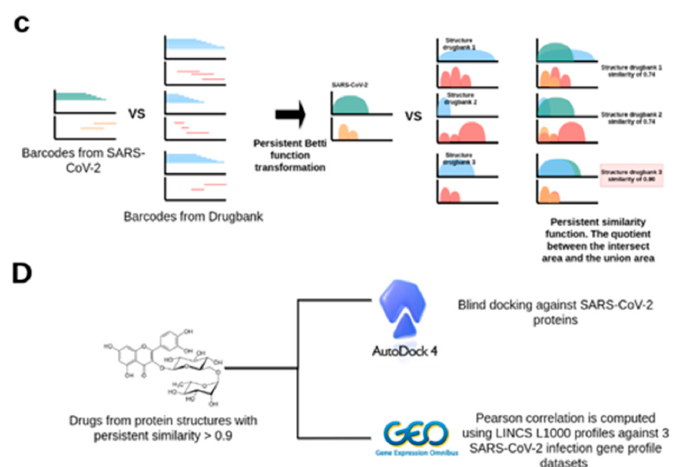
Figure 1. Bioinformatic work-flow used. ( A ) Data preprocessing and acquisition ( B ) Topological data analysis phase, Vietoris–Rips complexes at scale ε are computed to generate the barcodes. Each ε -associated Betti number captures a unique topological feature of the protein. ( C ) To compare barcodes of viral proteins against structures with known drugs, it is necessary to transform barcodes into comparable curves using persistent Betti functions (PBFs). ( D ) Candidate drugs from proteins with a mean persistent similarity score above 0.9 were validated by a dual in silico strategy. We used Auto-Dock 4 to analyze the capacity of the drug to bind against viral proteins. Transcriptomics analysis was performed to test the capacity of the candidate drugs to revert the transcriptomics effect induced by the COVID-19.